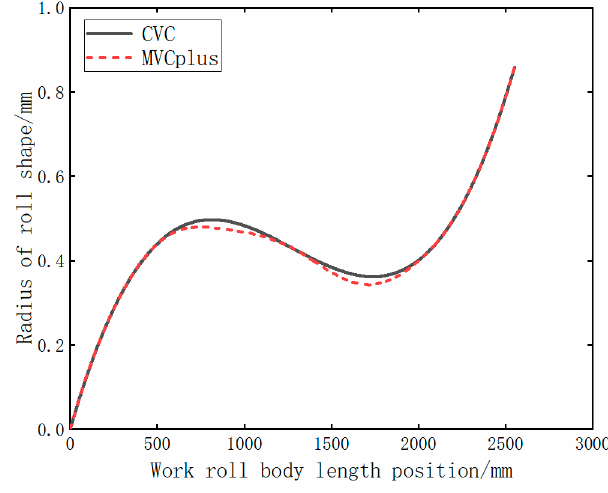
Figure 8. Curve of MVCplus after superposition.